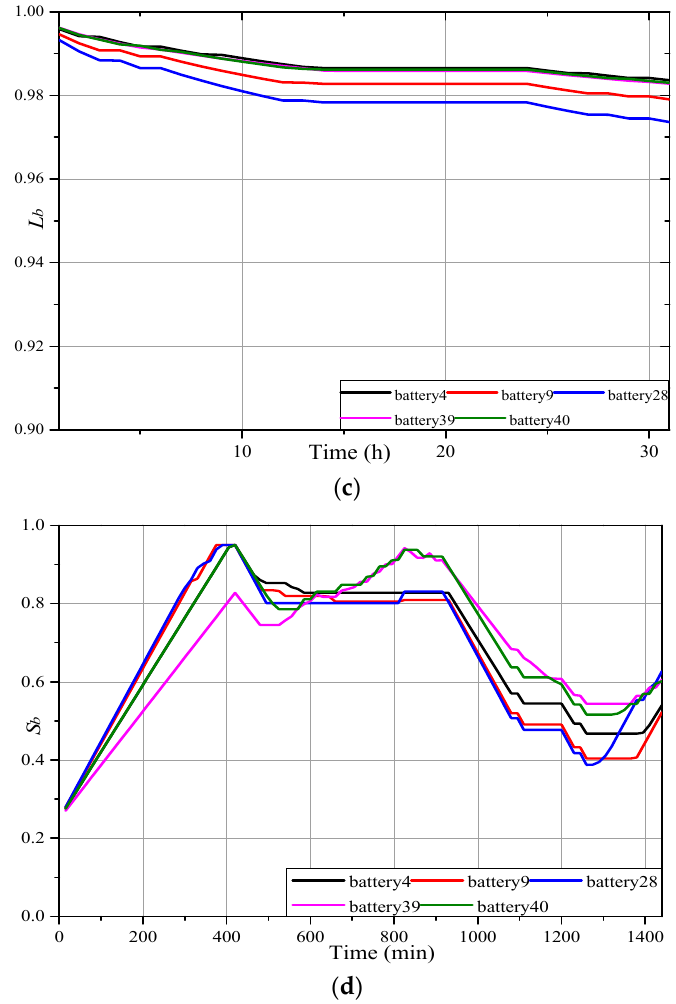
Figure 10. Curves of batteries: ( a ) Lifetime L b of batteries only used for voltage regulation; ( b ) SOC S b of batteries only used for voltage regulation; ( c ) Lifetime L b of batteries used for voltage regulation and price arbitrage; ( d ) SOC S b of batteries used for voltage regulation and price arbitrage.